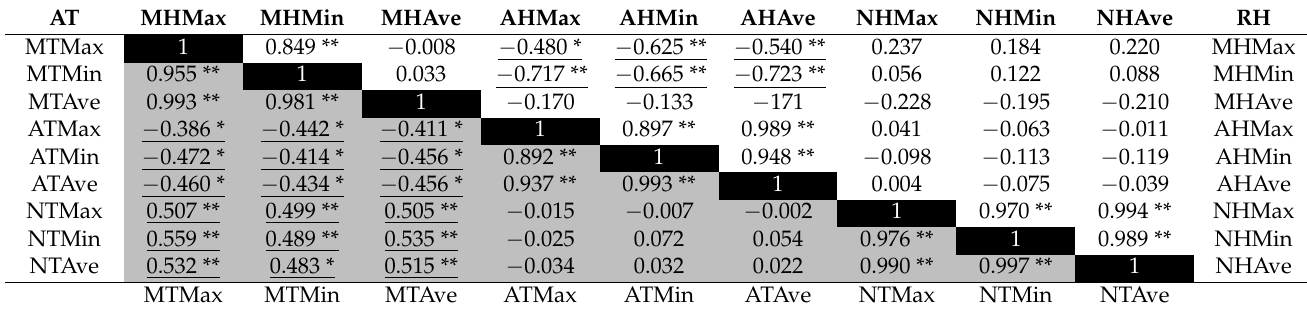
Table 5. Pearson’s correlation coefficients between air temperatures (relative humidity) at different times of the day for the commercial district ( n = 27).